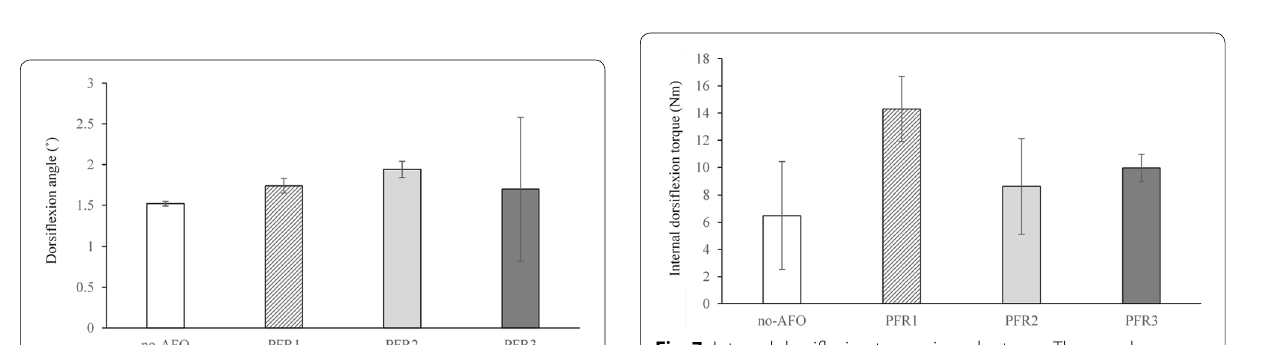
Fig. 7 Internal dorsiflexion torque in early stance. The error bars represent 1 standard deviation from the mean ±